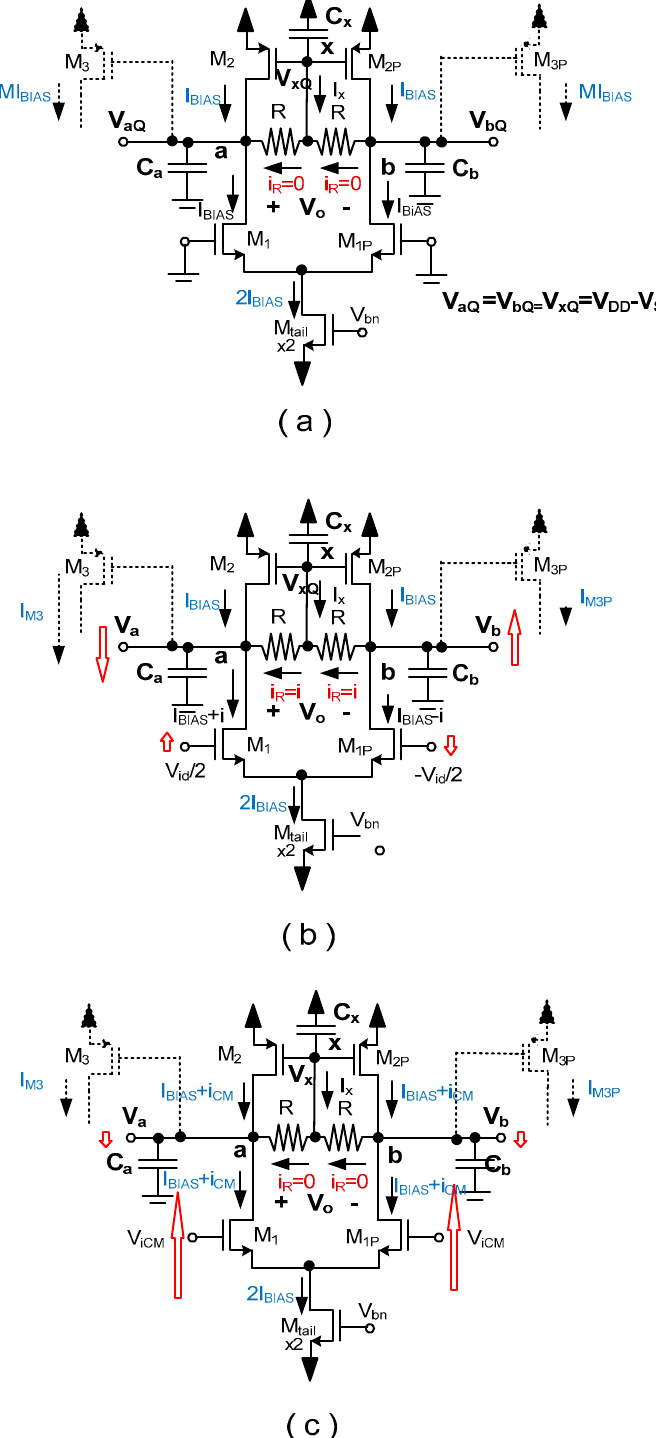
Figure 2. Operation of differential pair with RLCMFB: ( a ) Quiescent operation. ( b ) Operation with complementary differential inputs. ( c ) Operation with common mode inputs.